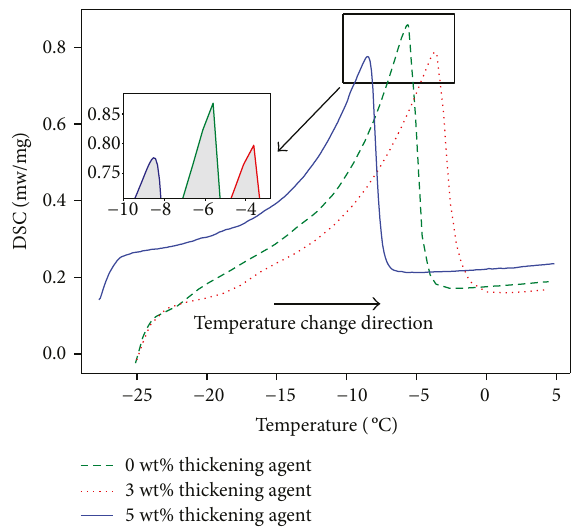
Figure 3: DSC curves of eutectic hydrate salt with three di ff erent amount of thickening agent.